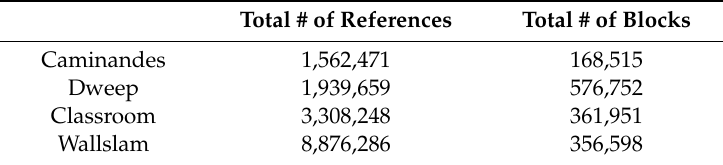
Table 1. Characteristics of traces used in